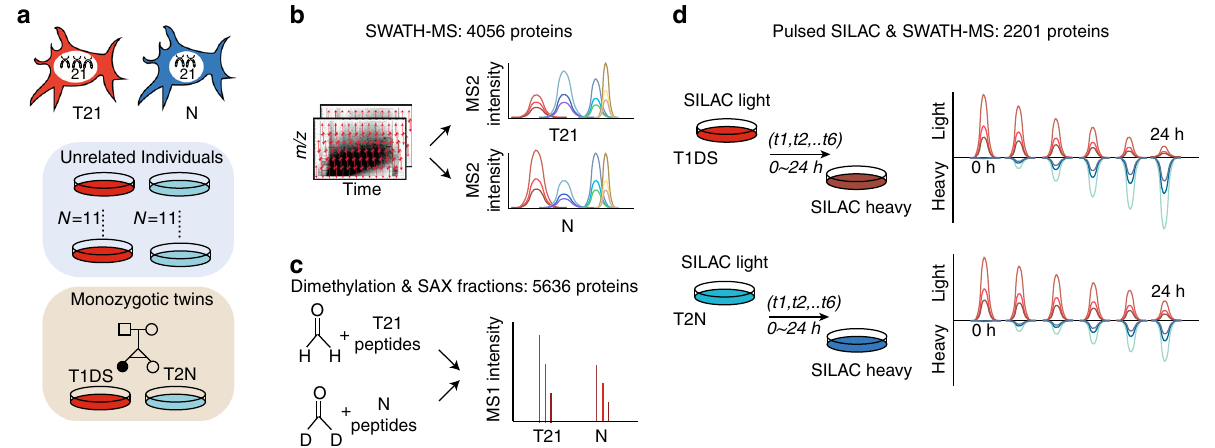
Fig. 1 Proteome and proteostasis investigation on T21 fi broblast cells. a Fibroblast cells collected from a pair of monozygotic (MZ) twins discordant for Trisomy 21 (T21), together with 11 unrelated T21 individuals bearing Down syndrome (DS) and 11 unrelated controls were used for analyzing the effect of T21. T1DS and T2N denote the T21 and normal twin used. b A reproducible and accurate data-independent acquisition mass spectrometry (DIA-MS) was used in conjunction with a massively parallel targeted data analysis strategy of SWATH-MS to pro fi le the proteomes. c A dimethylation labeling-based shotgun proteomics was used to measure protein abundance change in T21 and N sample mixtures. SAX strong anion exchanger. d A pulse SILAC (pSILAC) experiment determines the protein degradation and turnover rates in T1DS and T2N, respectively, across 6 time points over 24